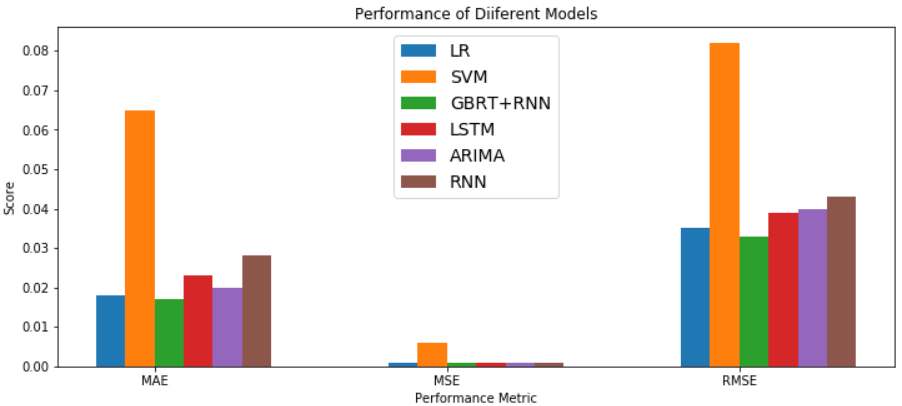
Figure 12. Comparison of Errors for accuracy analysis.